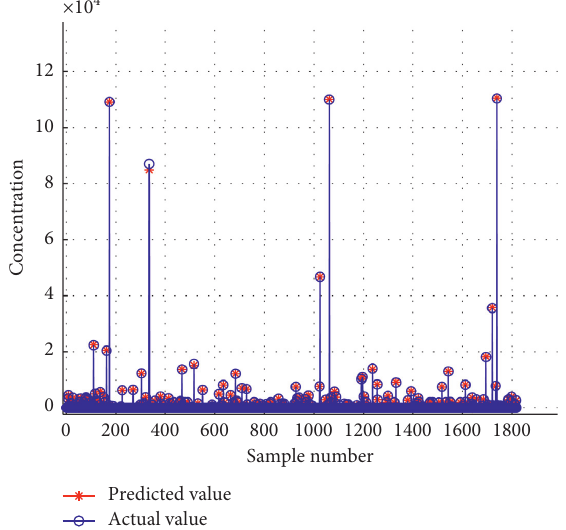
Figure 12: The fitting effect diagram of Weihai training set data.